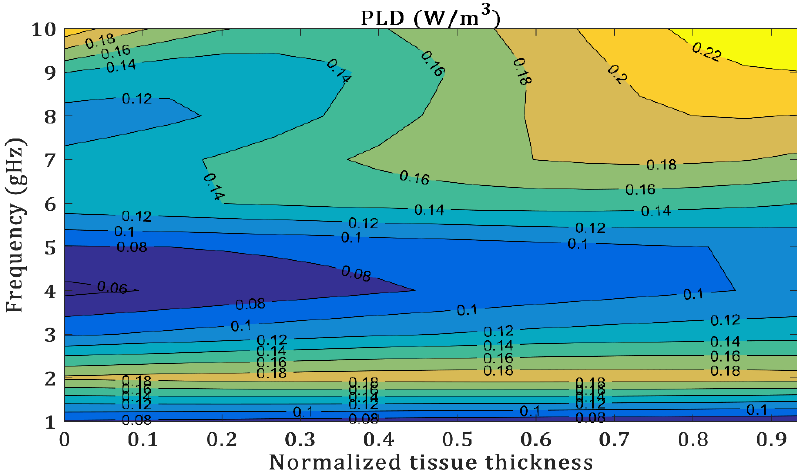
Figure 11. Power loss density only in skin.